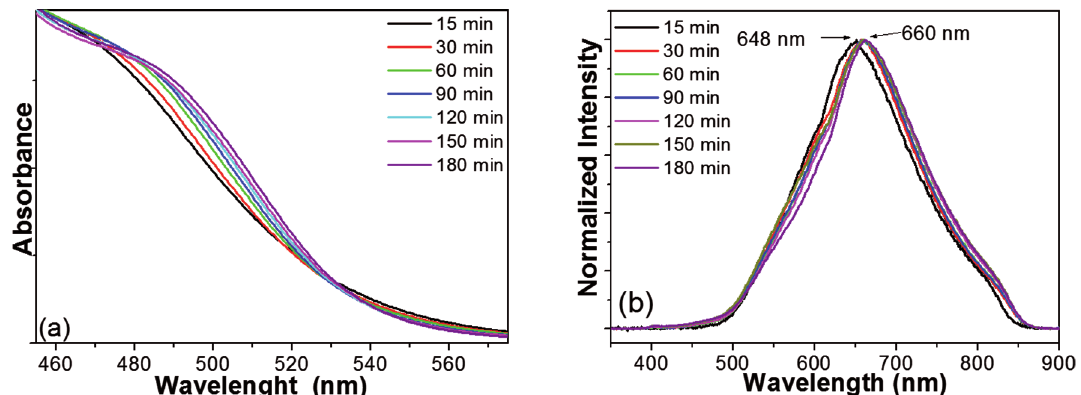
Figure 2: UV-visible absorption (a) and fluorescence (b) spectra of CdSe/MPA QDs at different reaction times.